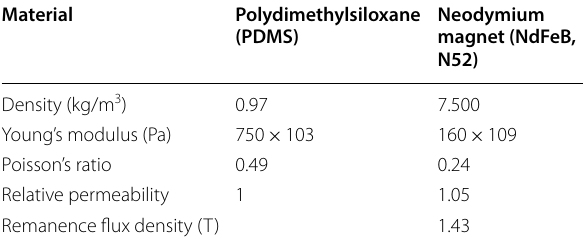
Table 1 Material properties of flexible microrobots used in mathematical modeling and establishment of the FEM